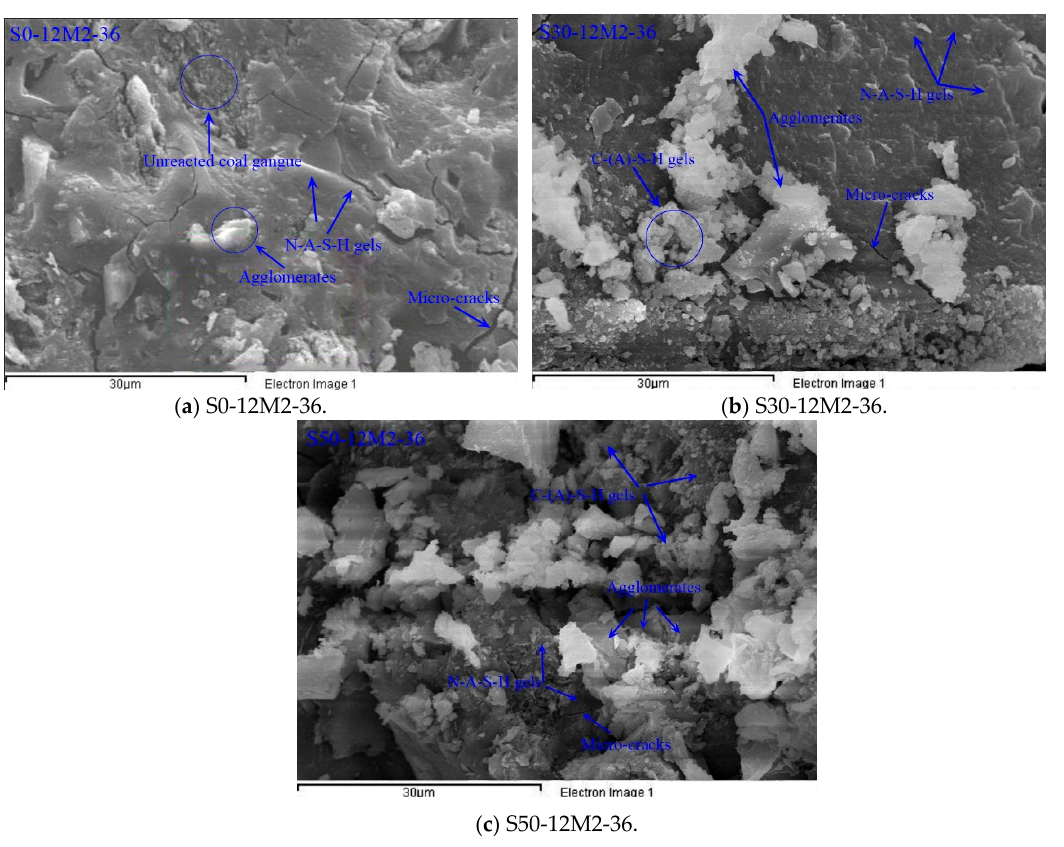
Figure 10. SEM-EDS analysis of the broken surface of the AACGS paste. ( a ) S0-12M2-36; ( b ) S30-12M2-36; ( c ) S50-12M2-36. Table 3. The average of the atomic percentage of each element in the three samples (At%).